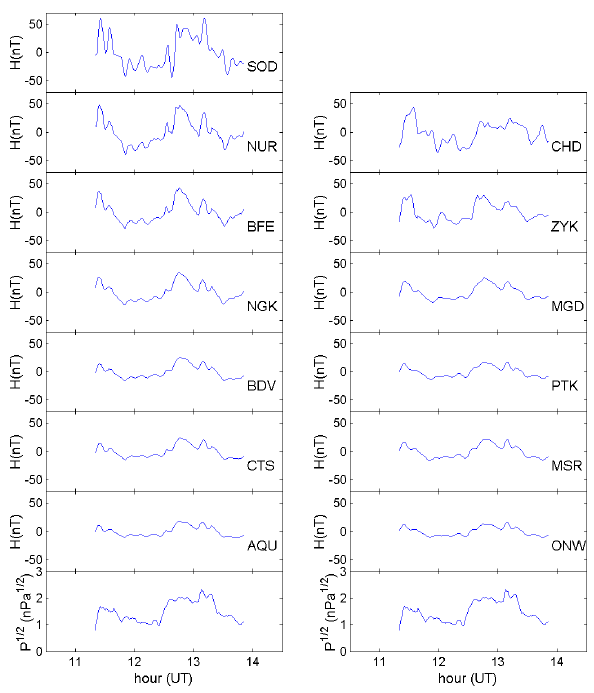
Fig. 7. The square root of the SW pressure and the H component at the different stations in the time interval 11:20–13:51UT (SW data are shifted for the time delay of 37 min).